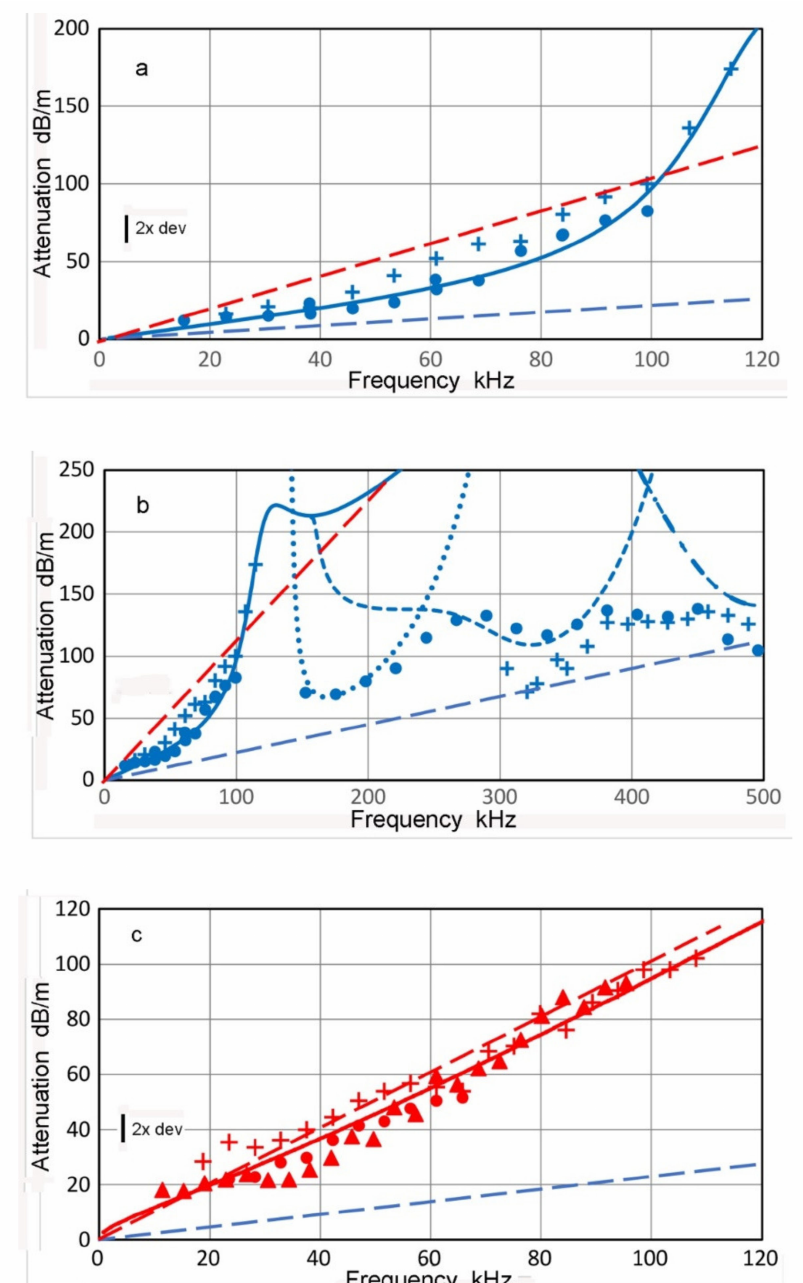
Figure 17. ( a ) Observed α –S o values for 7.1-mm HDPE plate with the calculated attenuation and dashed lines for α L and α T . Two test series are plotted using blue symbols. Both used Olympus V101 Tx and KRN-BB-PC Rx, with short-pulse excitation. Vertical bar shows 2 × dev. ( b ) Observed α –S values for 7.1-mm HDPE plate along with the calculated attenuation and dashed lines for α L and α T . Frequency range was extended to 500 kHz. Two test series and their symbols are identical to those in ( a ). Calculated attenuation curves included α –S 1 (blue dotted curve) and α –S 2 (blue short-dash curve). ( c ) Observed α –A o values for 7.1-mm HDPE plate using red symbols. Dot data used NDT C16 Tx at 60 ◦ incident angle with 50-kHz single-cycle sinewave excitation and KRN-BB-PC Rx. The other two series used NDT C16 Tx at 60 ◦ incident angle with short-pulse excitation and KRN-BB-PC Rx. The calculated attenuation and dashed lines for α L and α T are also plotted. Vertical bar shows 2 ×